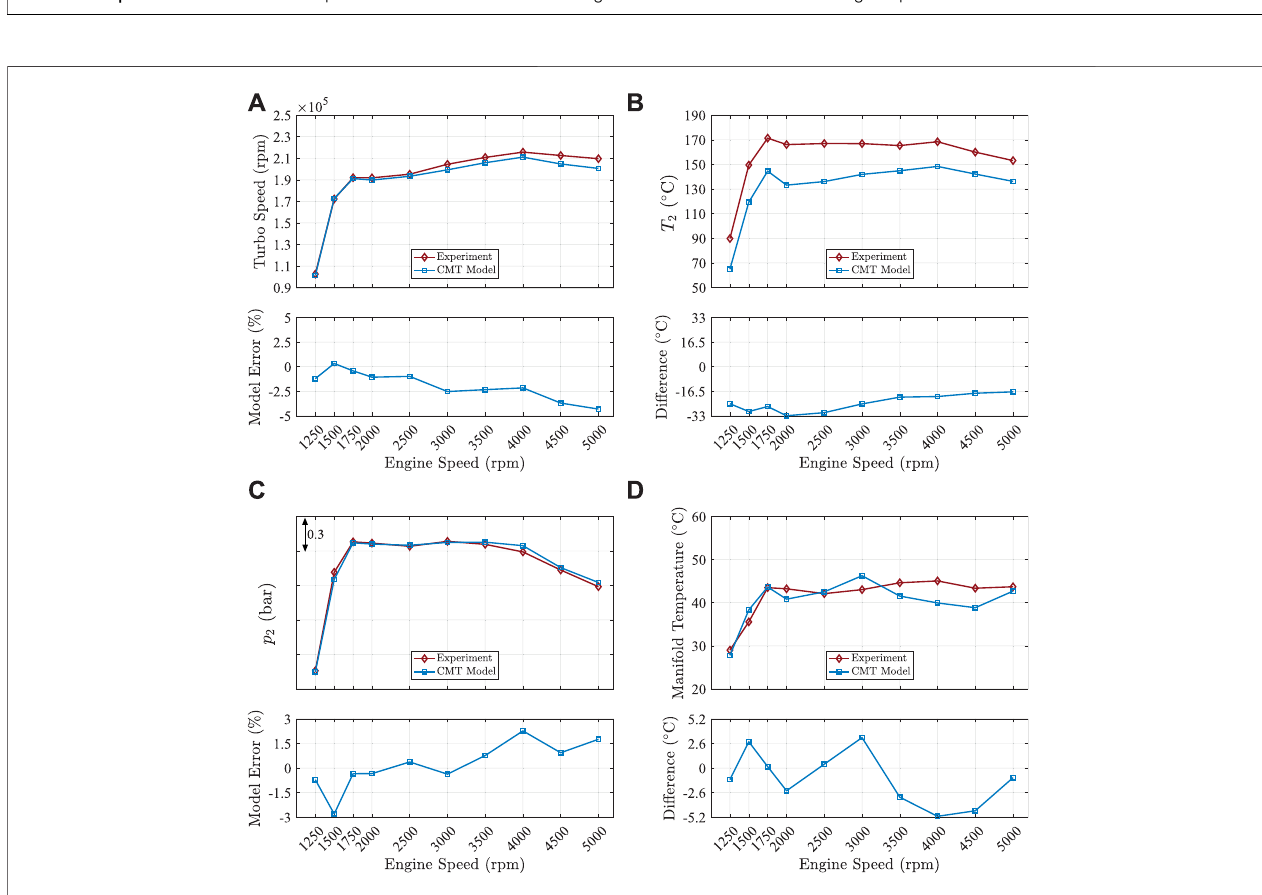
FIGURE 13 | Validation parameters of SCV opened simulation. Outputs from the CMT-DETCM model compared against the experimental data at different engine speeds. (A) Turbocharger speed; (B) compressor outlet temperature; (C) compressor outlet pressure; (D) inlet manifold temperature.